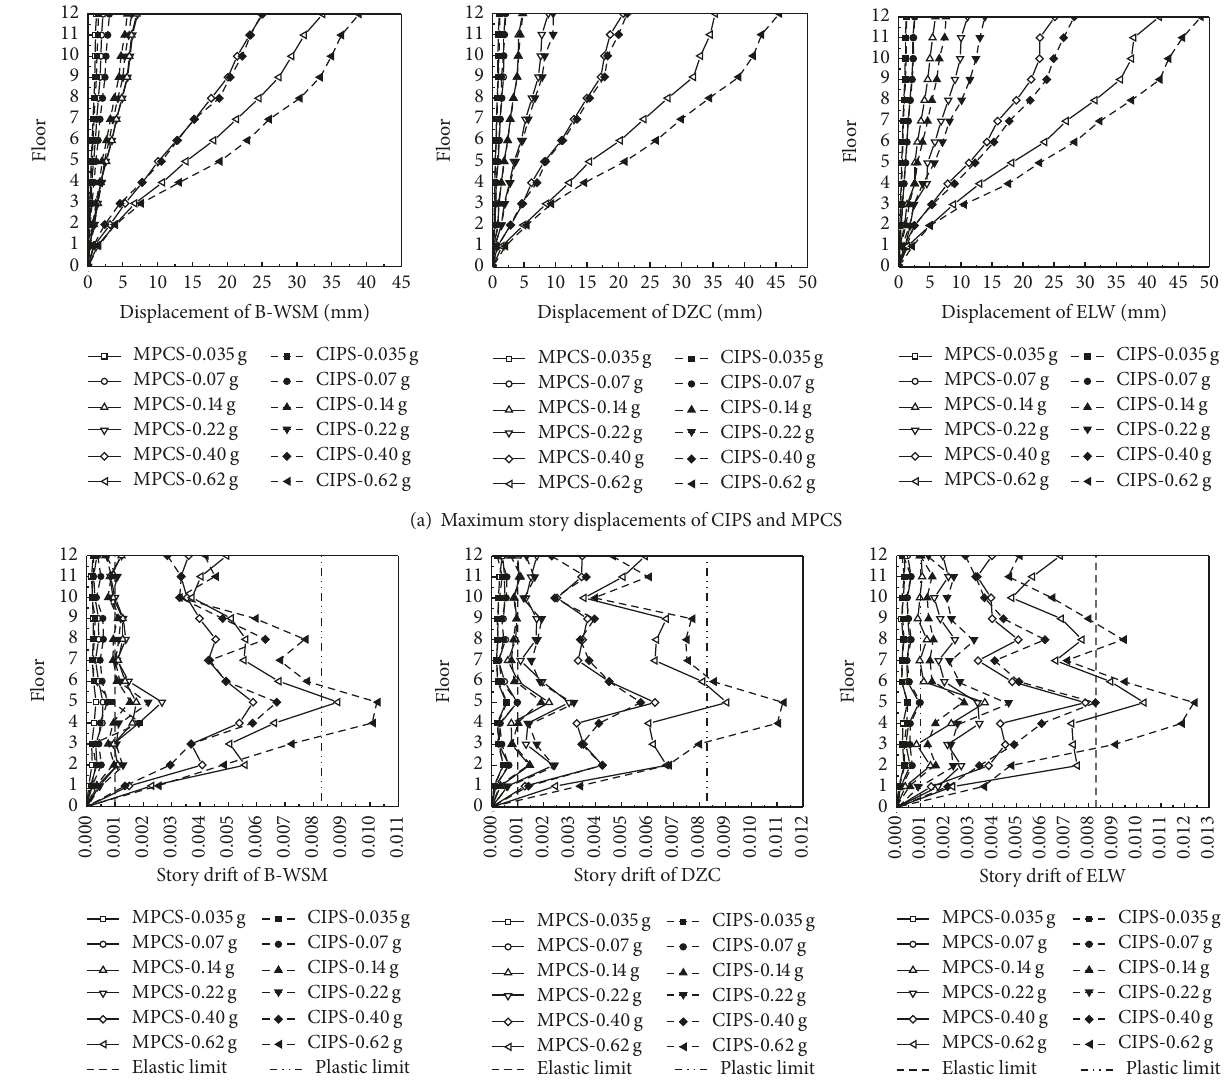
Figure 12: Displacement responses of CIPS and